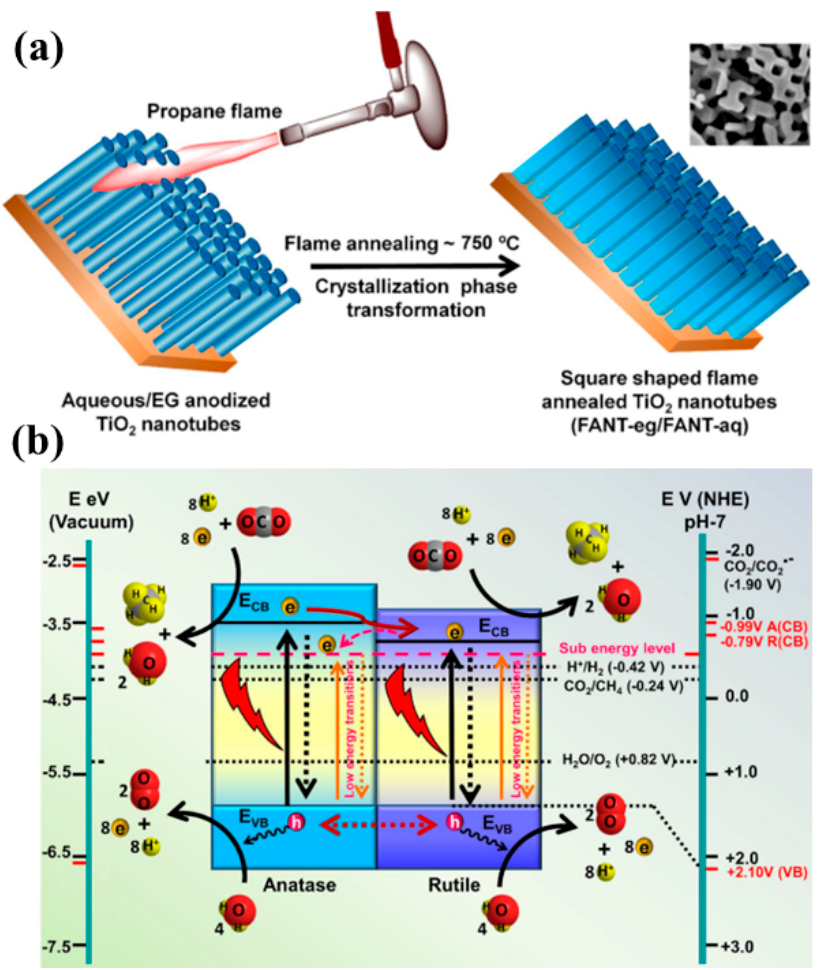
Key Parameters for Ref. Improved Performance Ref.